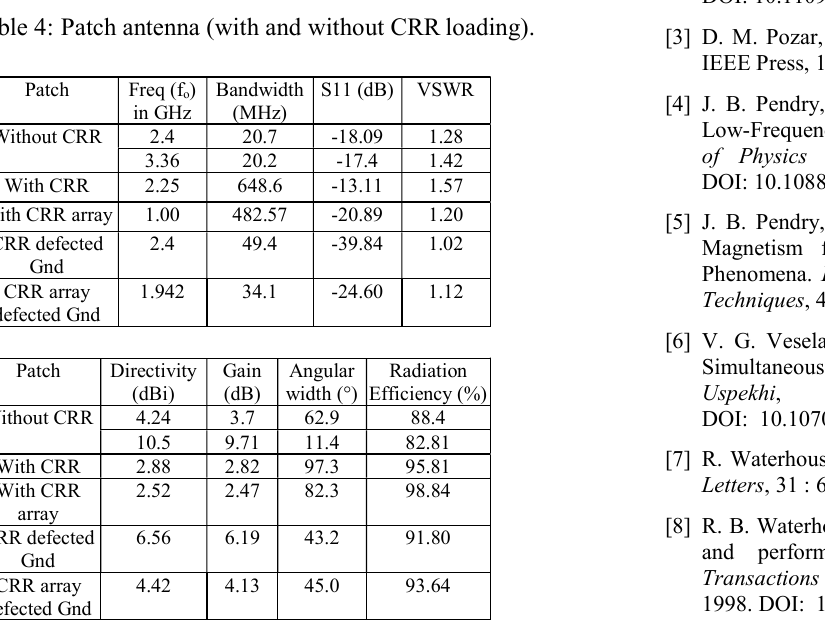
Table 4: Patch antenna (with and without CRR